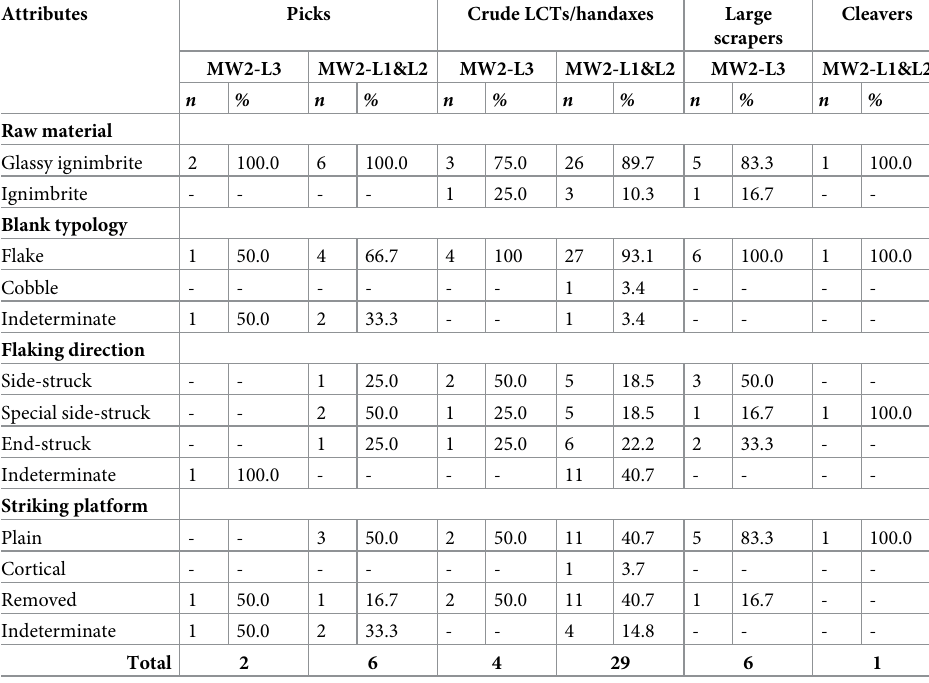
Table 8. Physical and technological attributes of LCTs in the MW2 assemblages.